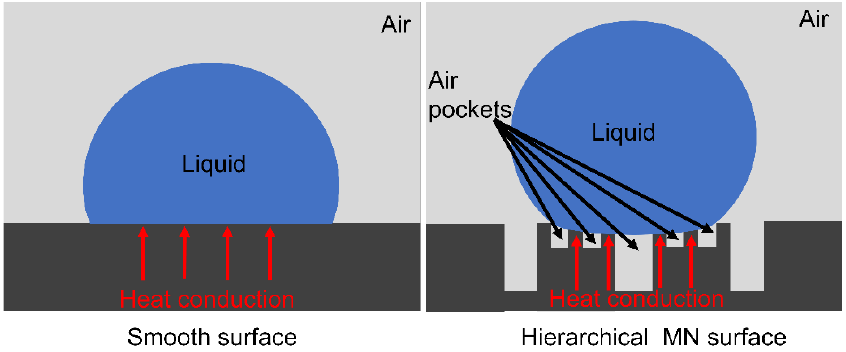
Figure 8. Heat conduction paths of smooth surface and hierarchical micro-/nanostructured sur-